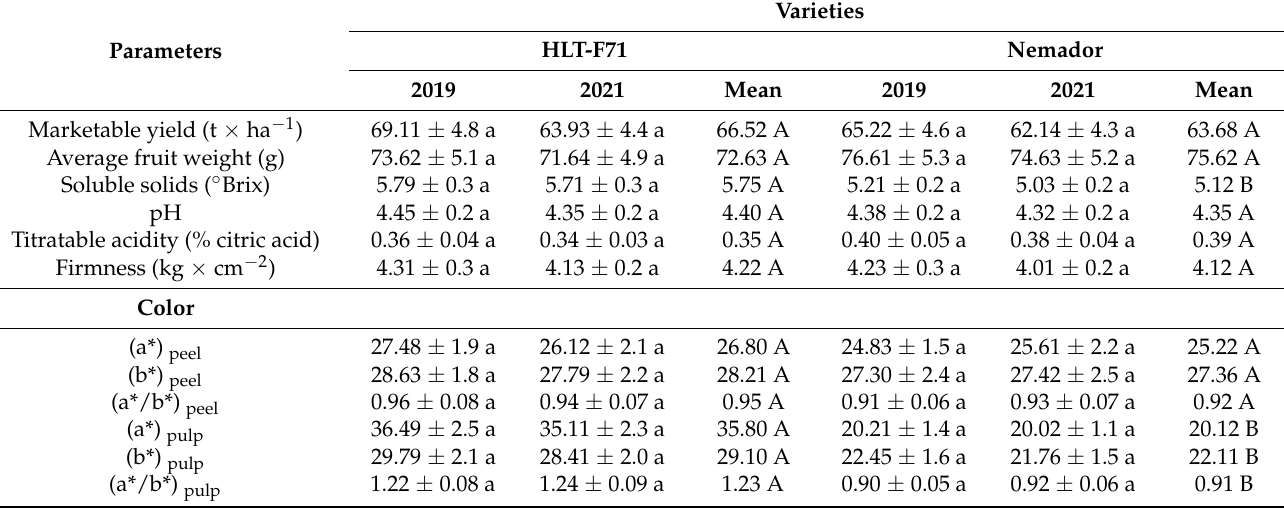
a Lower case letters indicate mean separation within row and variety; values with different letters were signifi- cantly different at p < 0.05 by LSD test. A,B Capital letters indicate mean separation among variety means within a row; values with different letters were significantly different at p < 0.05 by LSD